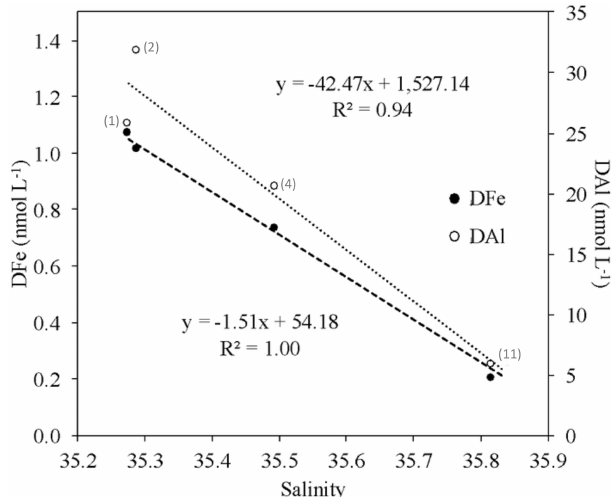
Figure 5. Plot of dissolved iron (DFe, filled circles) and dissolved aluminum (DAl, open circles; Menzel Barraqueta et al., 2018) at ∼ 20m, along the salinity gradient between stations 1, 2, 4, and 11 with linear regression equations. The numbers close to sample points represent the station